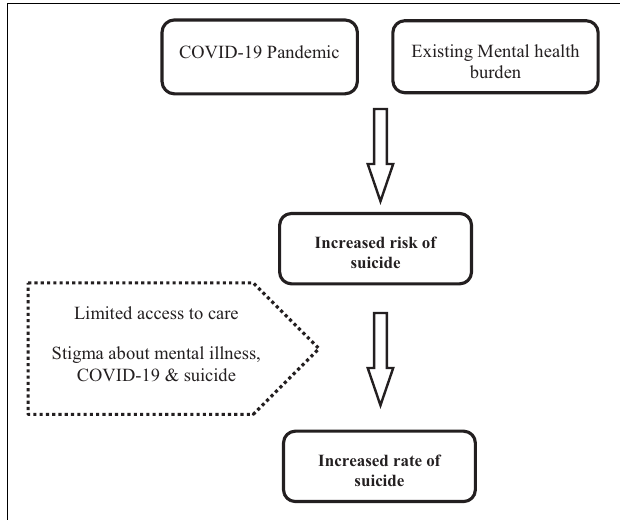
FIGURE 1 | Relationship between COVID-19 pandemic, stigma and risk of suicide.